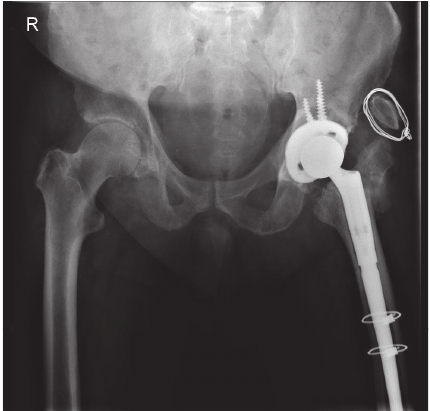
Figure 17: Postoperative anteroposterior pelvic plain film radio- graphs showing second-stage THR revisions in